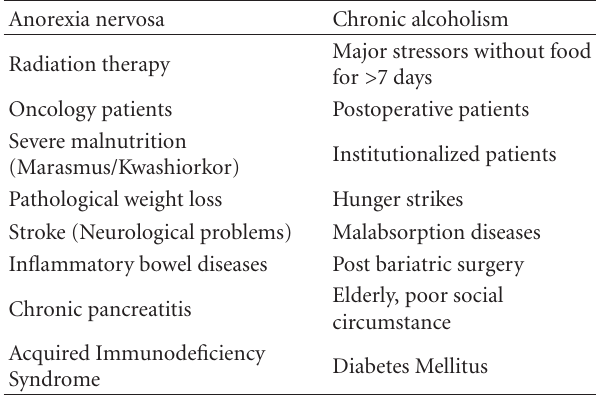
Table 2: Malnourished patients at risk of RFS [5, 6, 8, 29].